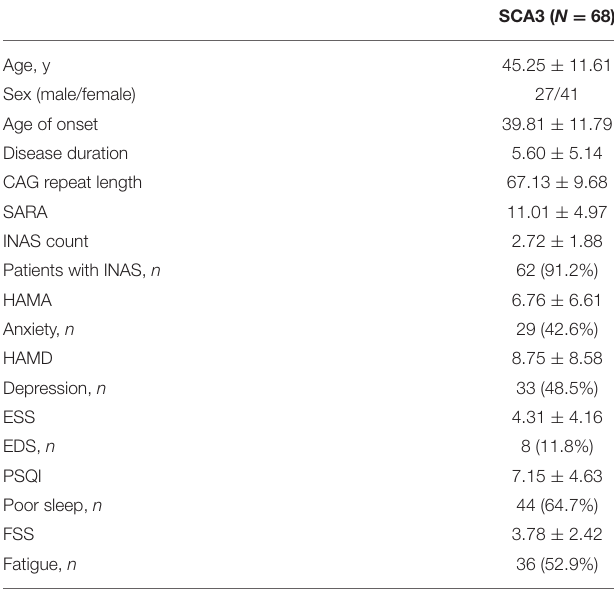
TABLE 1 | Clinical and demographic variables of SCA3 patients.